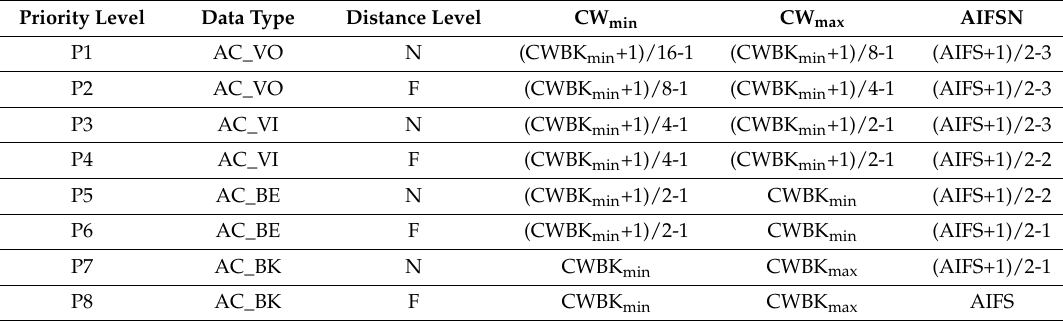
Table 2. Priority mechanism table.